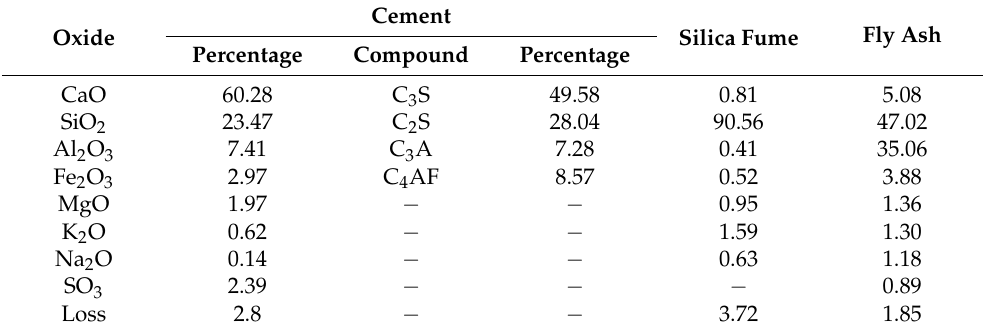
Table 1. Oxide compositions of cement, silica fume, fly ash and mineral compounds of the cement.